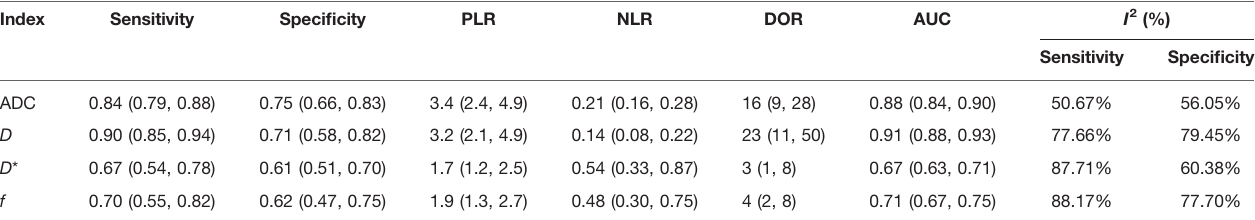
TABLE 5 | Pooled estimates and heterogeneity measures for ADC, D , D *, and f value. Index